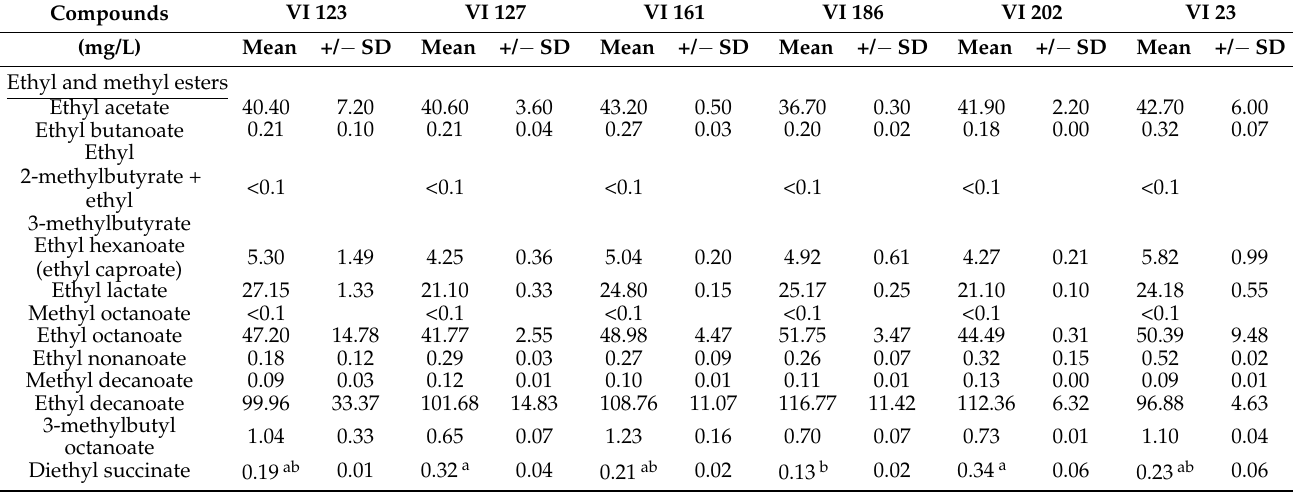
Table 3. SPE/GC-MS analysis of the wines obtained with the six indigenous strains. Values with different superscript letters (a, b, c) within a row indicate significant different concentrations between strains (ANOVA, p < 0.05).